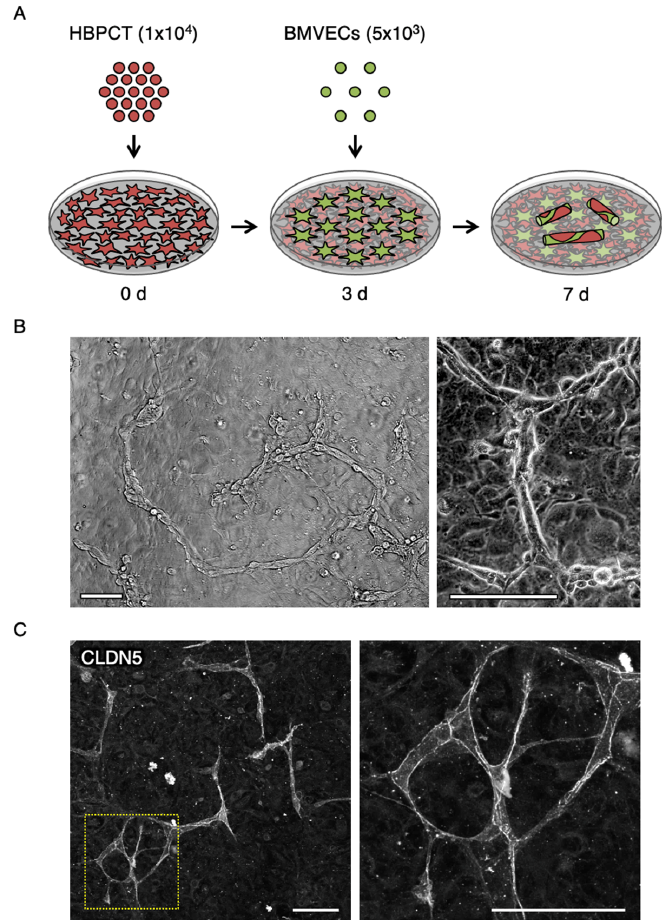
Figure 4. Formation of brain microvascular endothelial cell–pericyte tubes in two-dimensional co-culture. ( A ) Schematic method for two-dimensional co-culture system. HBPCT: human brain-derived pericyte cell line; BMVECs: human primary brain microvascular endothelial cells. ( B ) Phase-contrast micrograph showing tube-like structure. ( C ) Confocal images of two-dimensional co-culture stained for CLDN5. Scale bars, 100 µm.